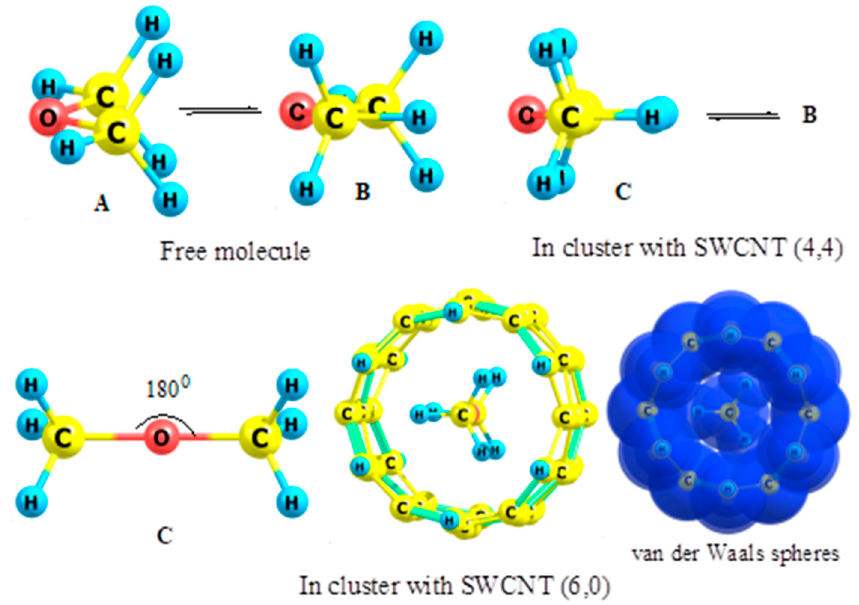
Figure 13. Conformations of dimethyl ether in the free state and in clusters with SWCNTs. Adapted with modification [194].